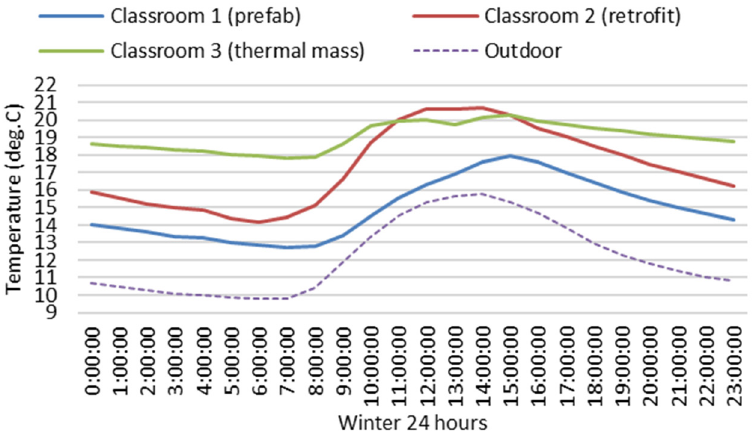
Figure 10. Winter indoor and outdoor hourly mean air temperatures of the three classrooms.